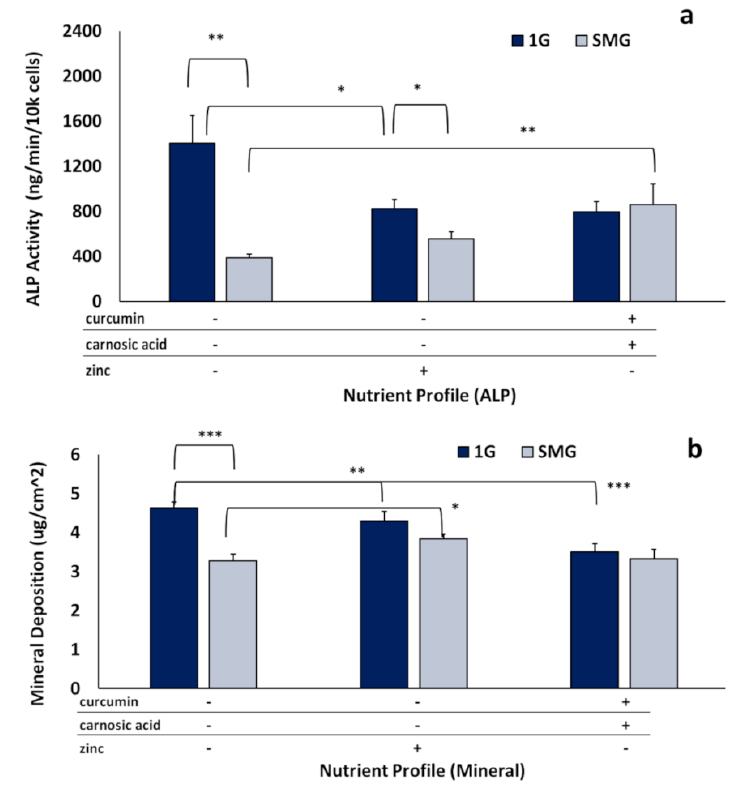
Figure 5. Effects of nutraceuticals on long-term ALP activity and mineral deposition. Long-term SMG experiments were conducted over 21 days in DM to assess enzymatic ALP and mineral deposition us- ing “optimal” nutraceutical mixes: (“phytonutrients”) 3.75 µ M curcumin + 12.5 µ M carnosic acid and (“zinc”) 25 µ M zinc. ( a ) ALP activity normalized by cell number. ( b ) mineralization quantified as mi- crograms of calcium per square centimeter ( µ g/cm 2 ). Asterisk (*) p < 0.05, (**) p < 0.01, (***) p < 0.001. The results reflect means ± SD from three independent experiments ( n = 3 biological